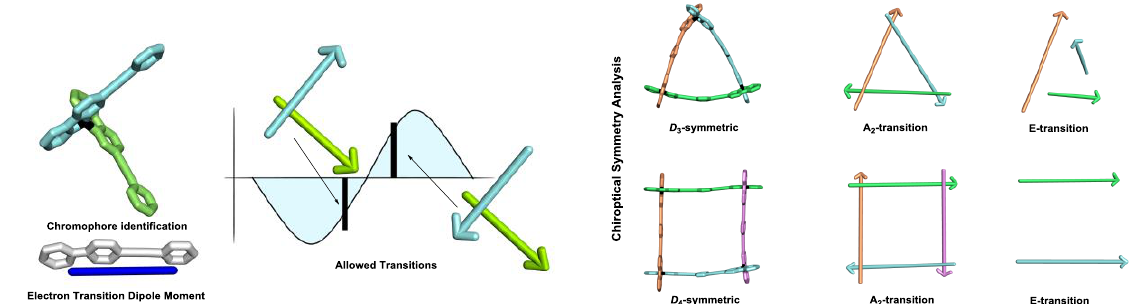
Figure 17. Example of exiton chirality ( left ) an chiroptical symmetry analysis ( right ).